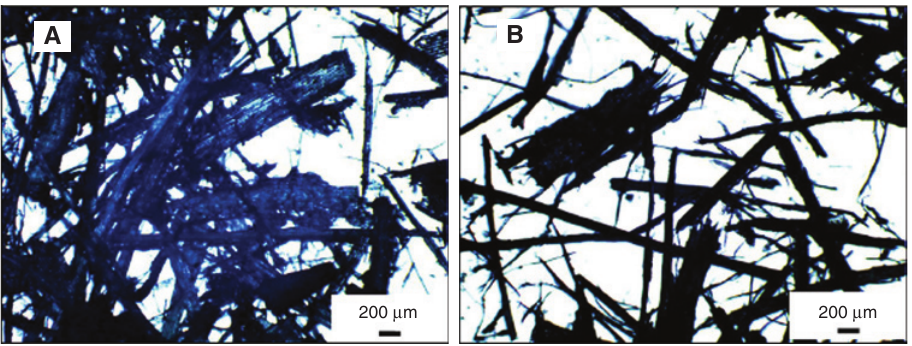
Figure 2 OM images for triticale (A) obtained from refining wet process and (B) after granulation.